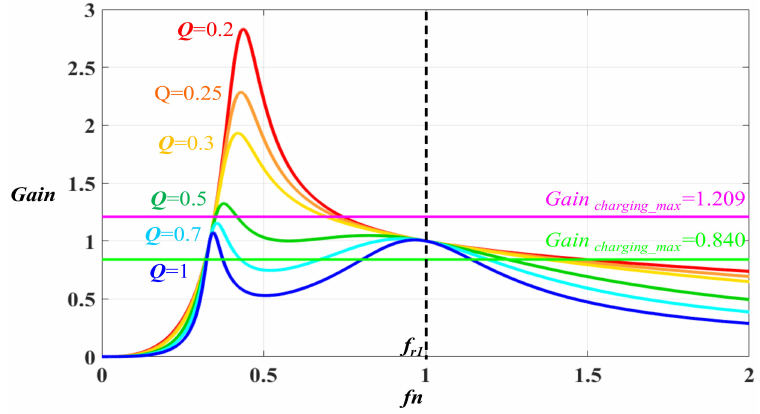
Figure 10. Voltage gain curves for different Q values.